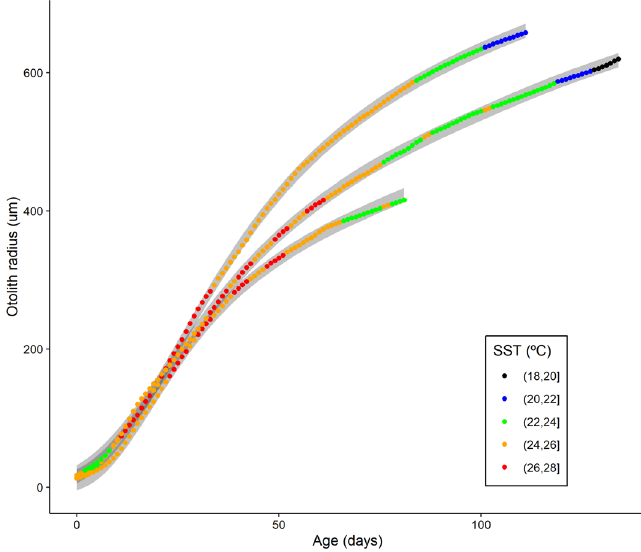
Figure 2. Adjustment of the temperature-dependent Gompertz growth model to three individuals selected for their contrasting characteristics of otolith growth, age, and thermal history. The observed values for each individual are presented as colored circles, where the color represents the temperature range estimated from satellite data. The confidence bands are plotted at 0.90 of the confidence interval for clarity. Graph created with